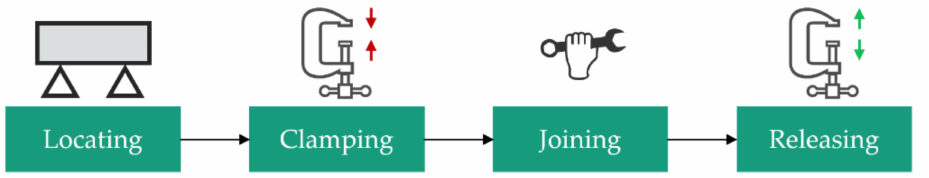
Figure 3. Generic joining process according to Dahlström et al.